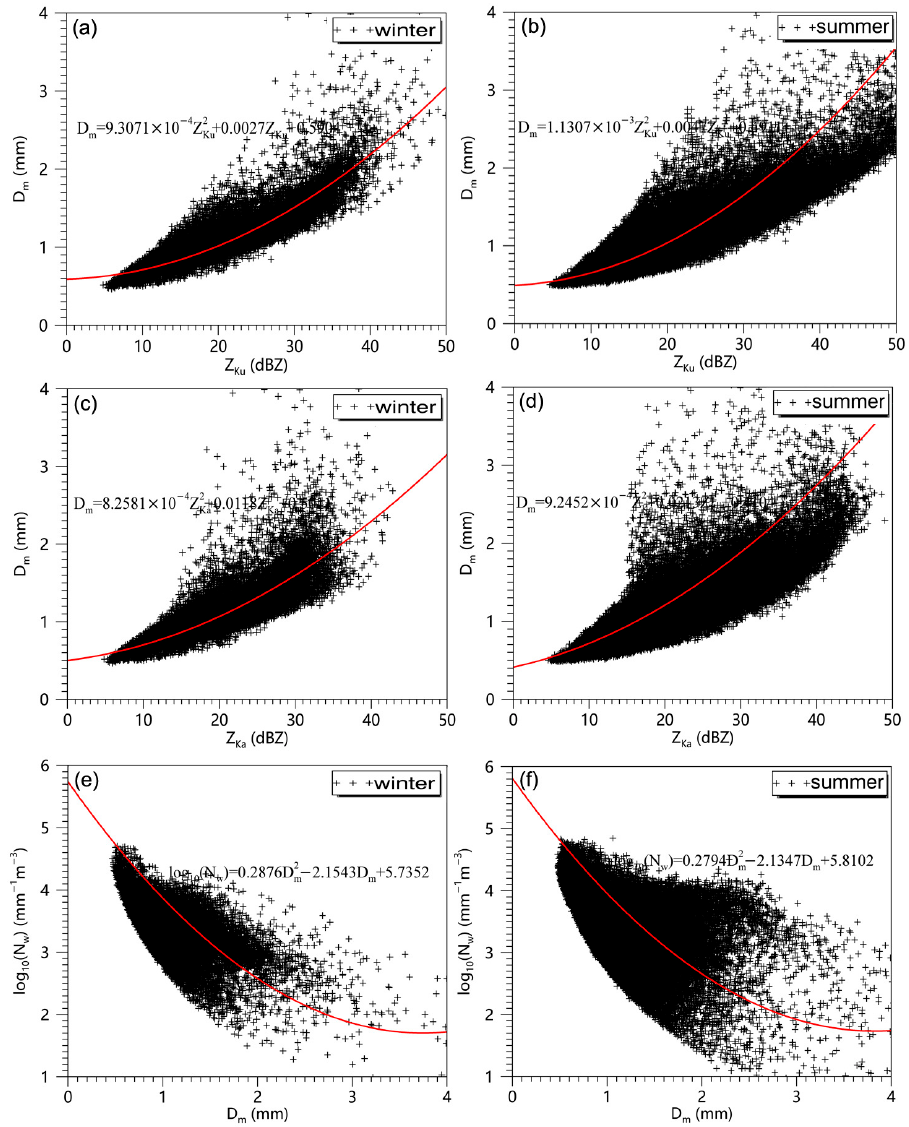
Figure 6. Scatterplots of D m (mm) and Z Ku (dBZ); D m (mm) and Z Ka (dBZ); log 10 ( N w ) (mm − 1 m − 3 ) and D m (mm) derived from the Parsivel disdrometer data for two seasons. The left ones stand for winter and the right ones for summer. The overlaid red lines represent the fitted curves.